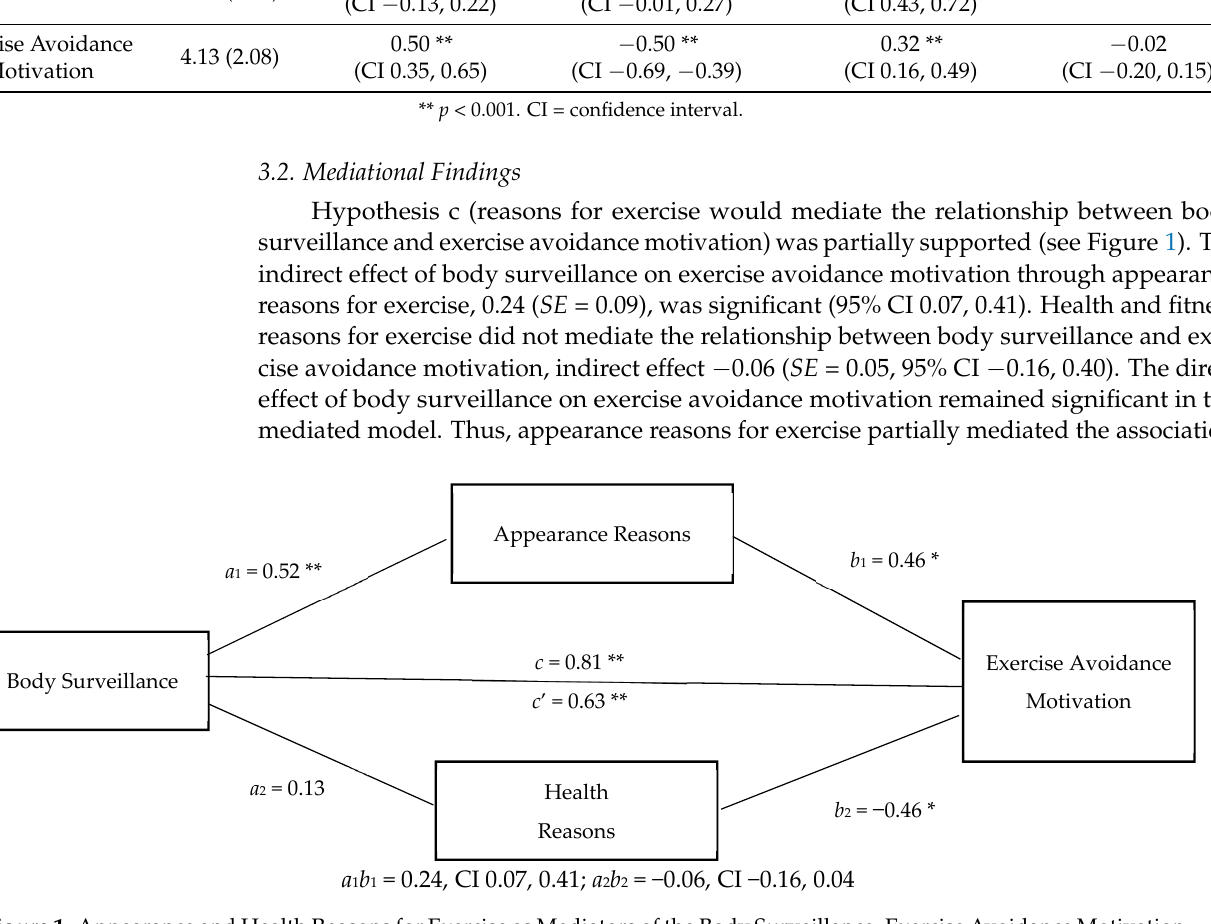
Figure 1. Appearance and Health Reasons for Exercise as Mediators of the Body Surveillance–Exercise Avoidance Motivation Relationship. * p < .05, ** p < .001.